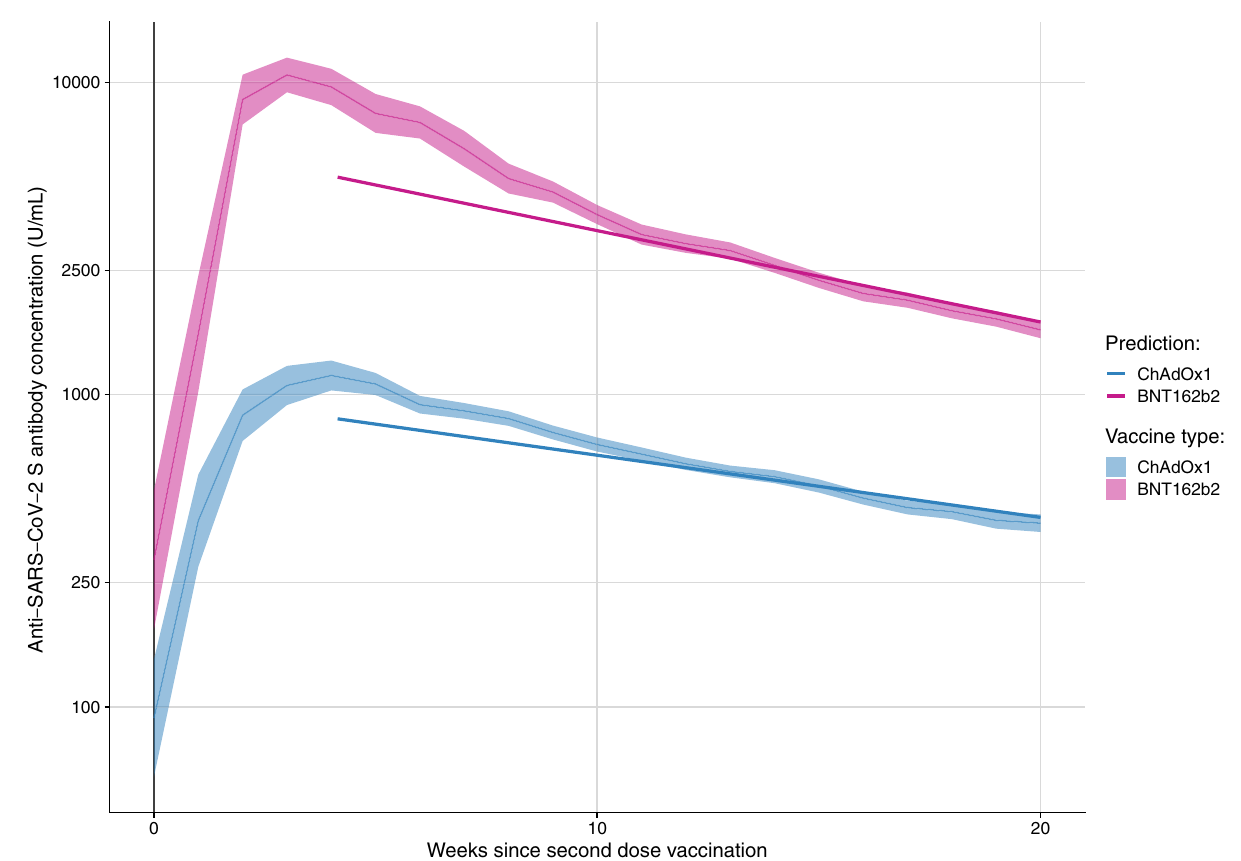
Fig. 1 | Geometric mean (with 95% con fi dence intervals) for anti-S samples (U/ ml)overtimesinceseconddoseofvaccination,andlevelspredictedbyalinear mixed effect model amongst N-seronegative individuals by vaccine type. Wanting anti-S levels followed a mean log-linear decline from 4 weeks after the seconddoseofvaccinationforbothvaccinetypes.Thegeometricmeanoftheanti-